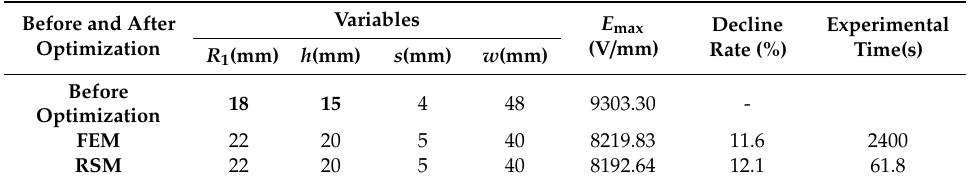
Table 10. Optimization results.